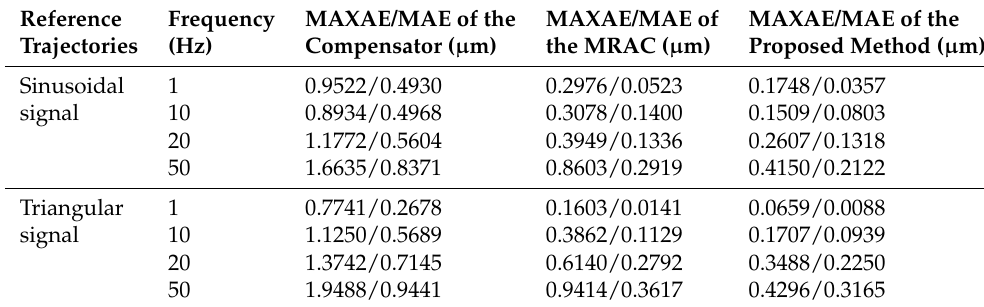
Figure 7. Tracking performance of the HAC approach in comparison with the compensator and MRAC under triangular reference trajectories of different frequencies: ( a ) tracking result at frequency of 1 Hz; ( b ) tracking result at frequency of 10 Hz; ( c ) tracking result at frequency of 20 Hz; ( d ) tracking result at frequency of 50 Hz. Table 2. Tracking performance of different controllers under different reference